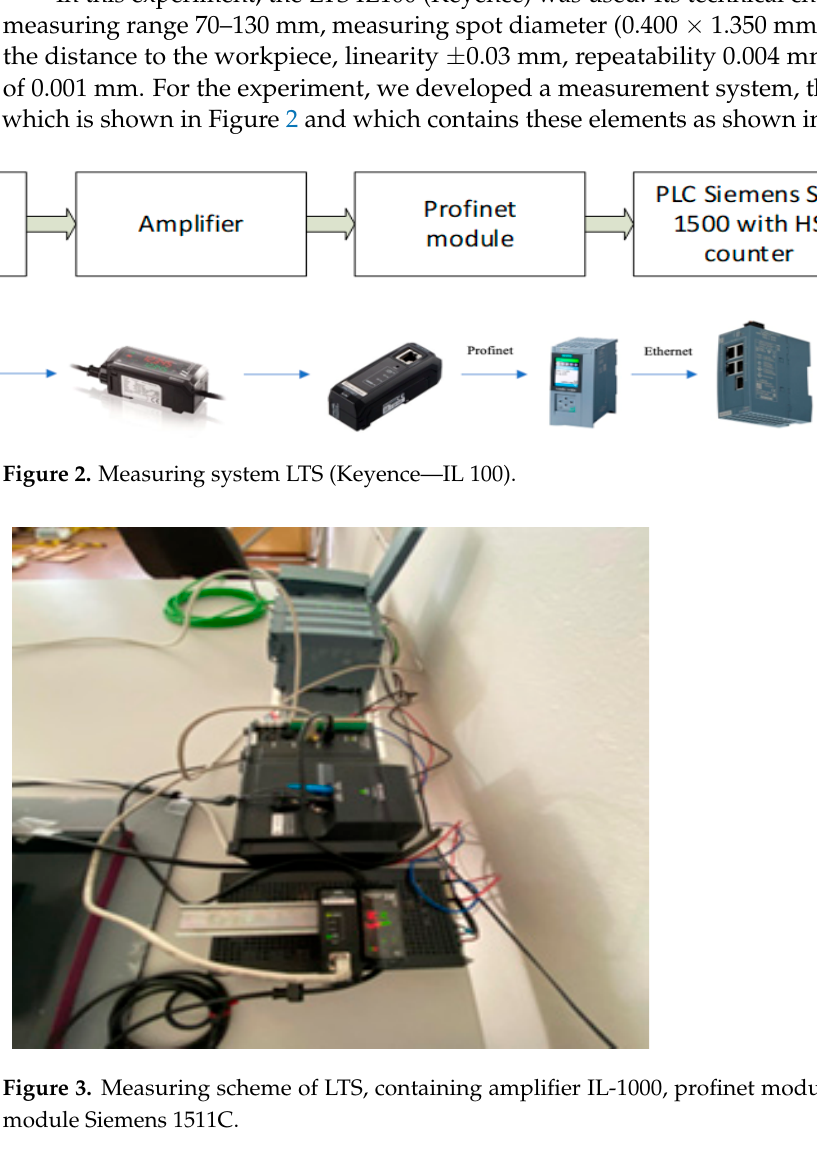
Figure 3. Measuring scheme of LTS, containing amplifier IL-1000, profinet module DL-PN1, PLC module Siemens 1511C.